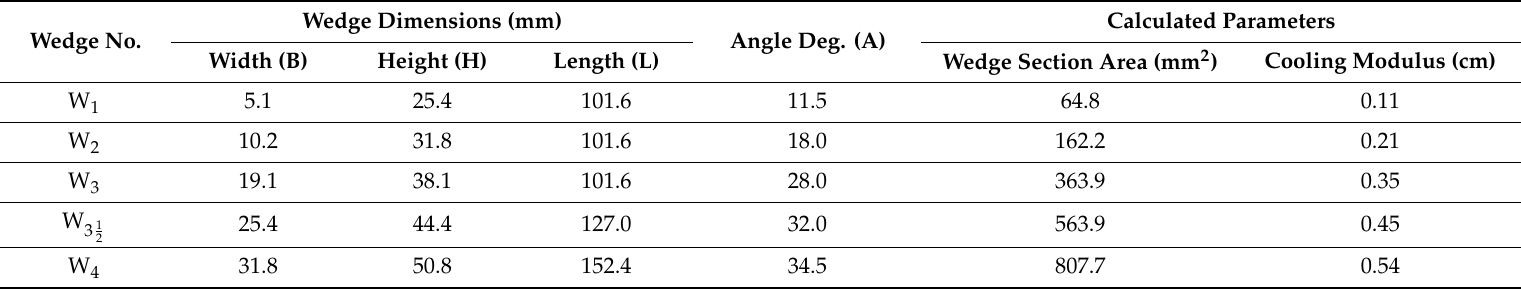
Table 2. Dimensions of Standard Test Wedges (ASTM